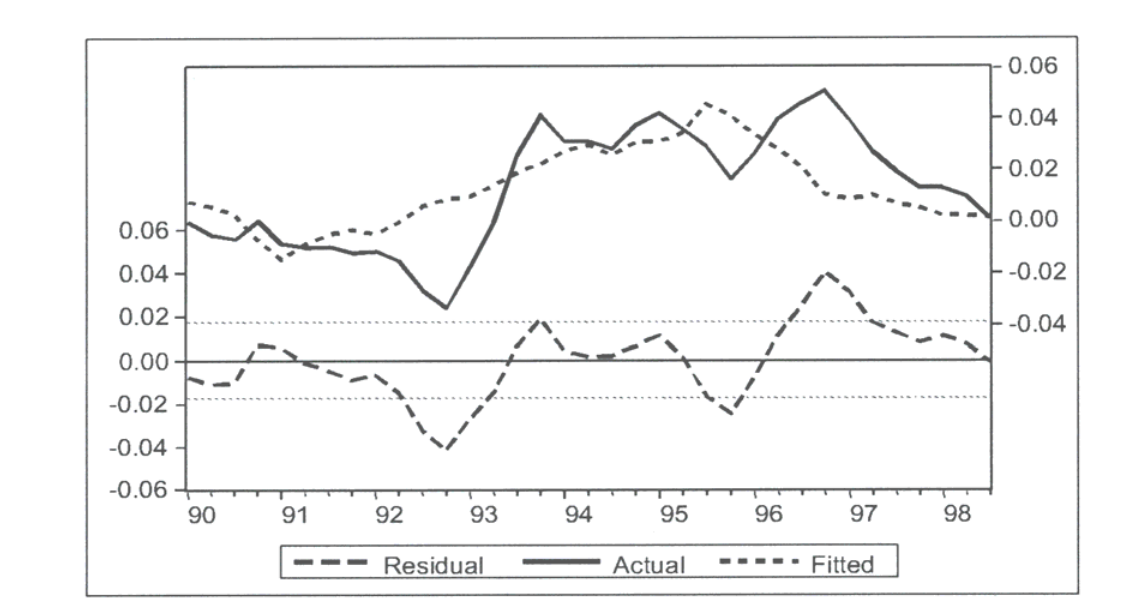
Goodness-of-fit of regression of yield curve on